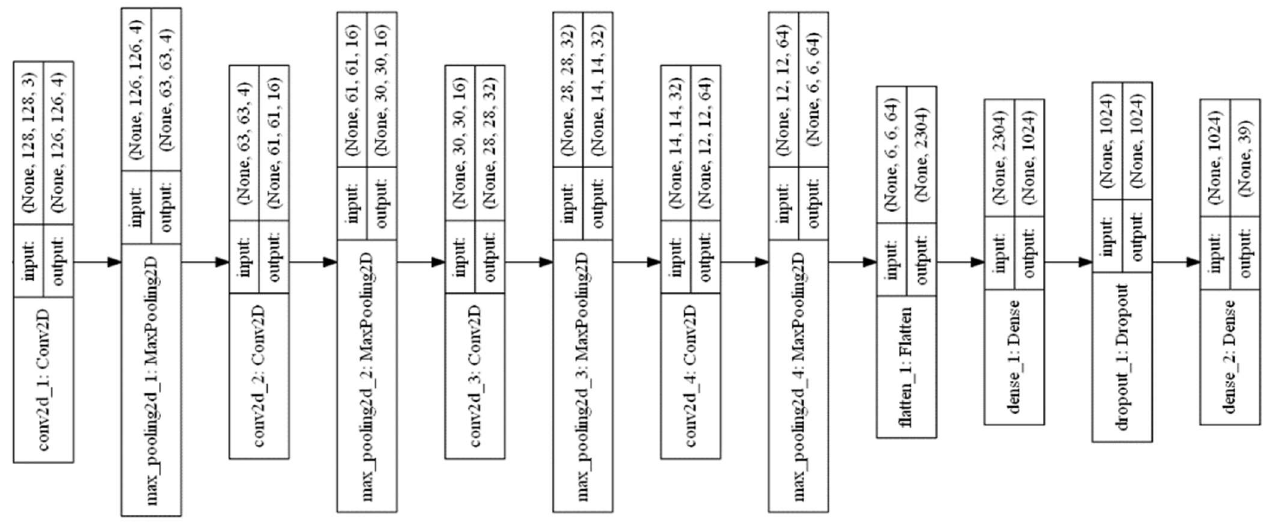
Figure 12. Layered structure of Conv-4 DCNN model.